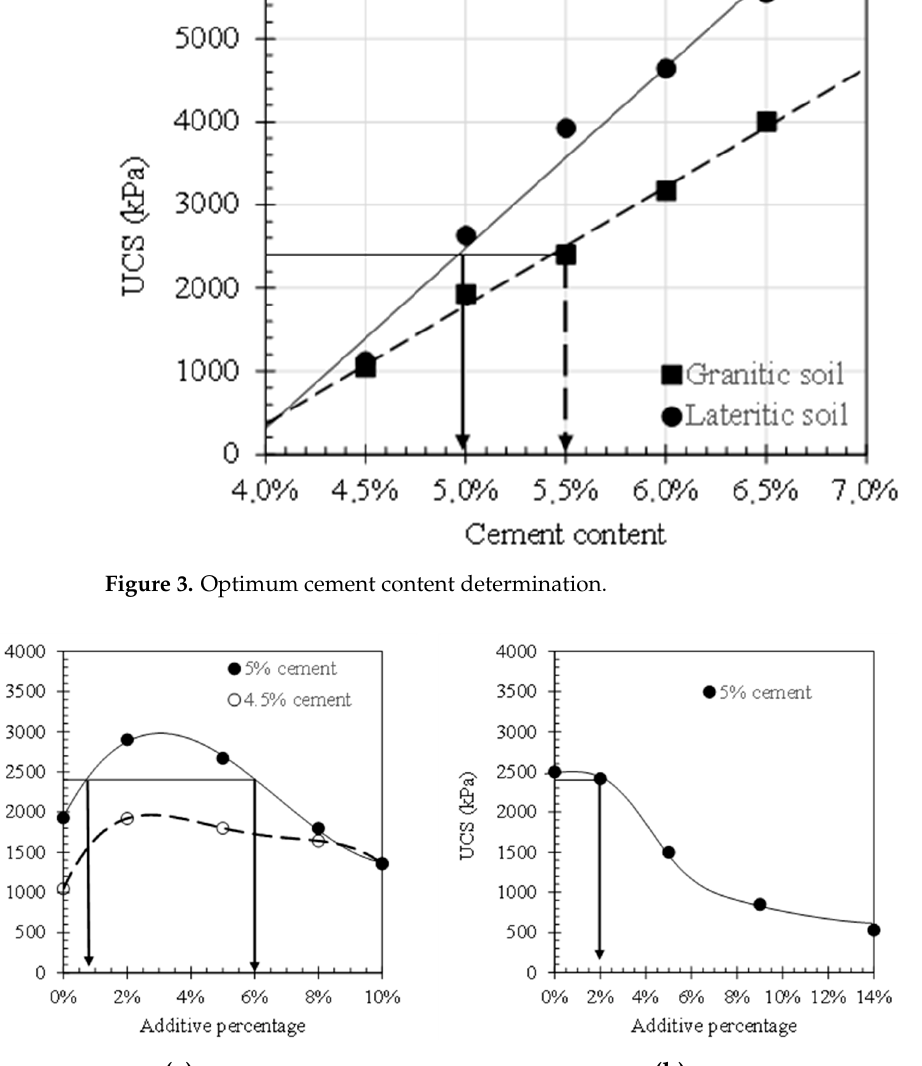
Figure 4. Determination of additive percentage in the mixture. ( a ) Granitic soil, and ( b ) lateritic 215 soil.